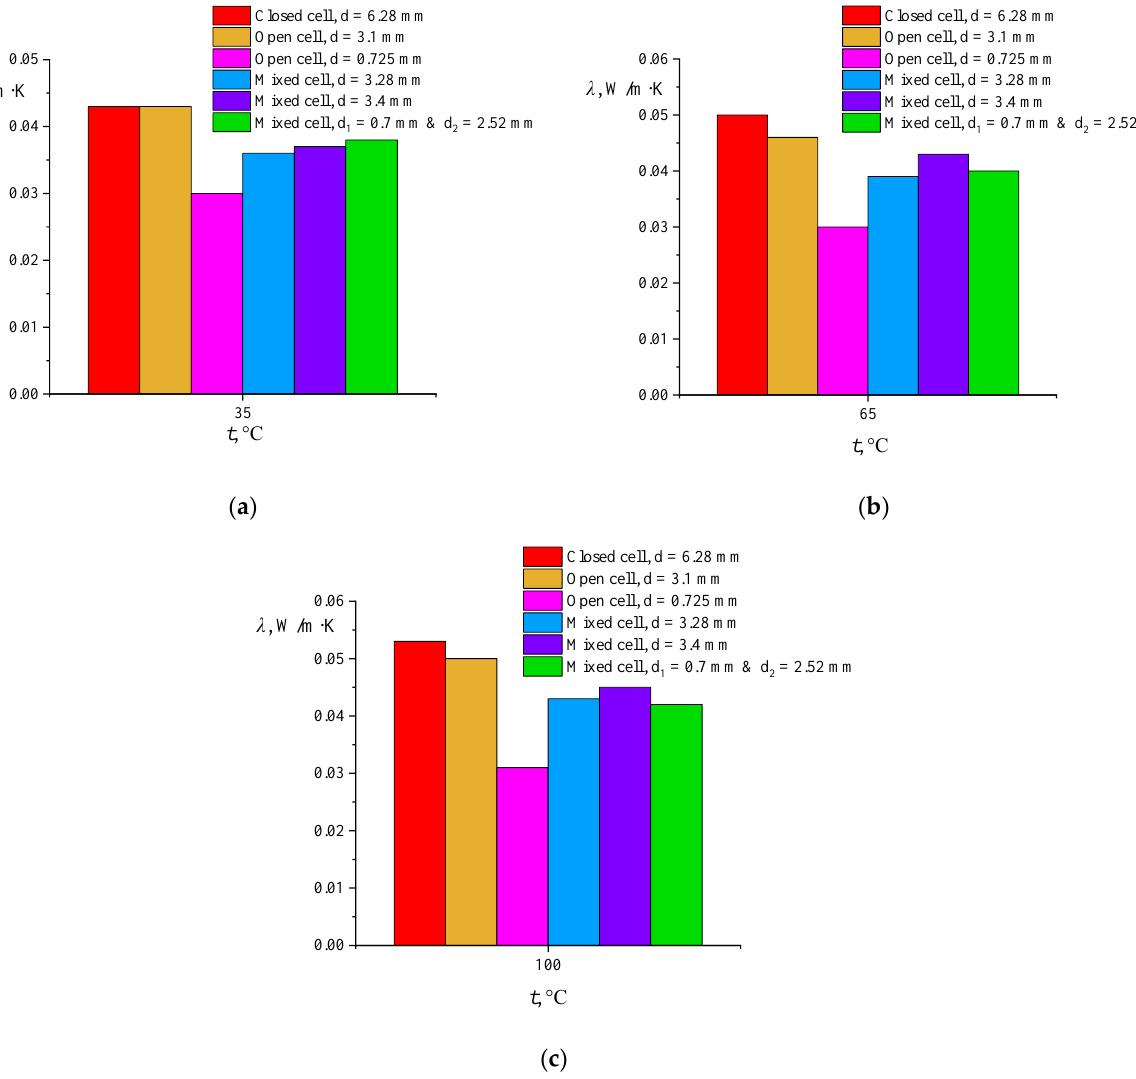
Figure 9. Diagrams of effective thermal conductivity values of foams at different temperatures: ( a ) at low temperature 3 5 °С ; ( b ) at an average temperature 6 5 °С ; ( c ) at high temperature 10 0 °С .